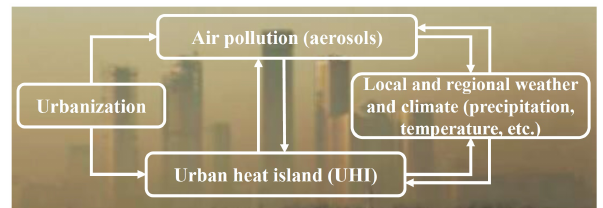
Figure 1. Illustration of the relationship between urbanization, ur- ban heat island, aerosols, local and regional weather, and climate. Solid arrows denote the